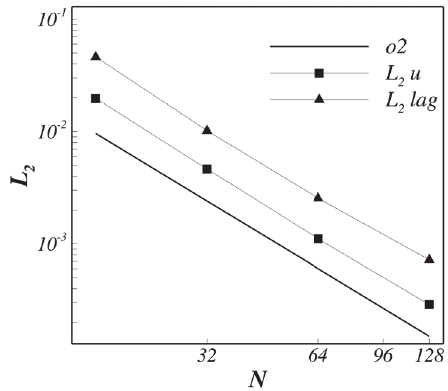
Figure 7 - L 2 norm of the Zero Mach Number manufactured solution. ■: u, ▲: L 2 of the immersed boundary. The solid line stands for the second order